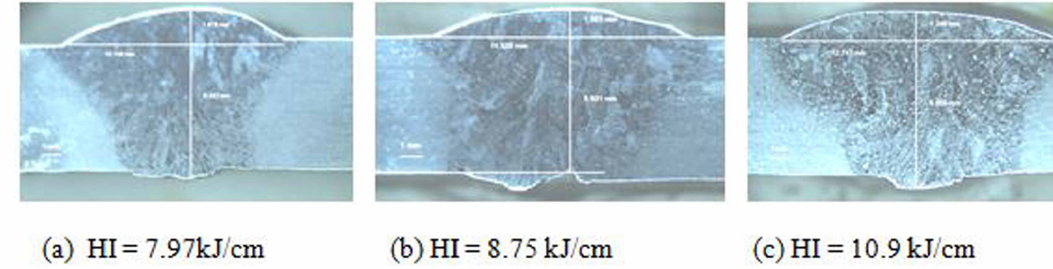
Figure 1. Macrograph of GTAW weld joints Table 3. Measured δ ferrite content in the weld deposits Exp.